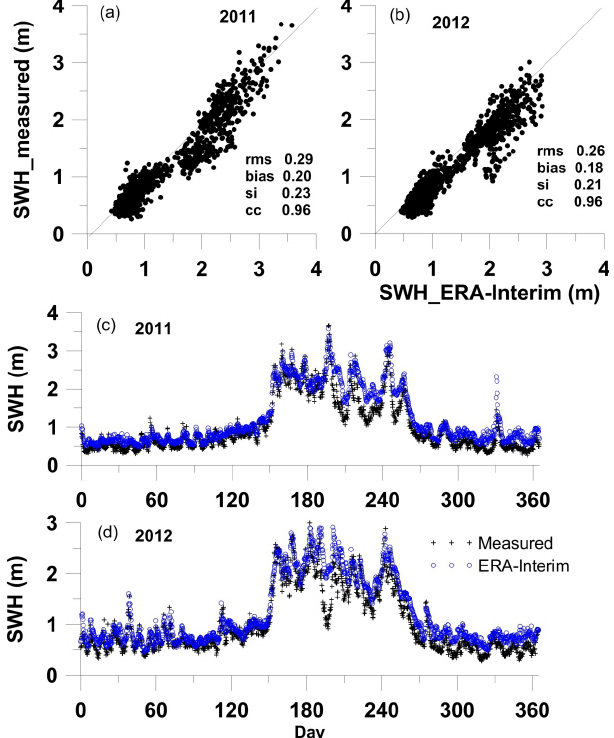
Figure 2. a) Scatter plot showing the comparison of significant wave height based on ERA- 451 Figure 2. (a) Scatter plot showing the comparison of significant wave height based on ERA-Interim and the measured buoy data dur- Interim and the measured buoy data during 2011 and b) during 2012 c) time series plot of the 452 ing 2011 and (b) during 2012; (c) time series plot of the significant significant wave height based on ERA-Interim and the measured data during 2011 and d) during 453 wave height based on ERA-Interim and the measured data during 2011 and (d) during 2012. 454